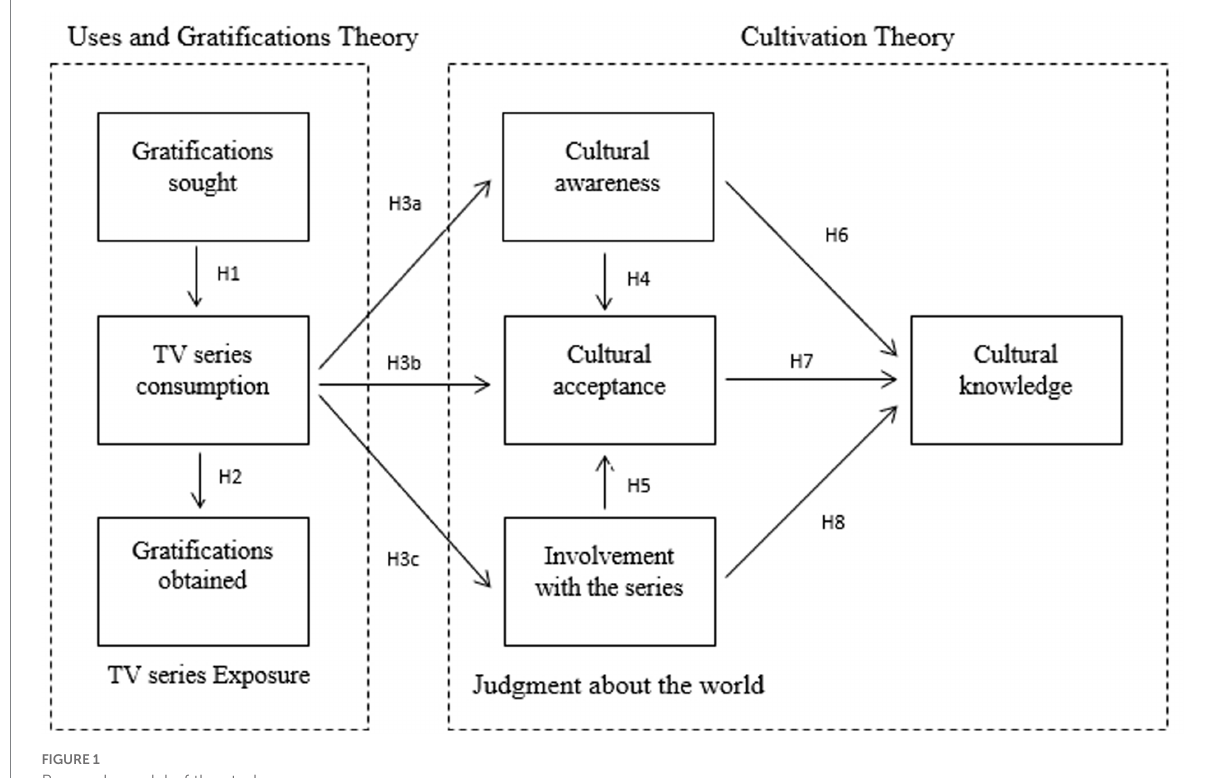
FIGURE 1 Research model of the study.